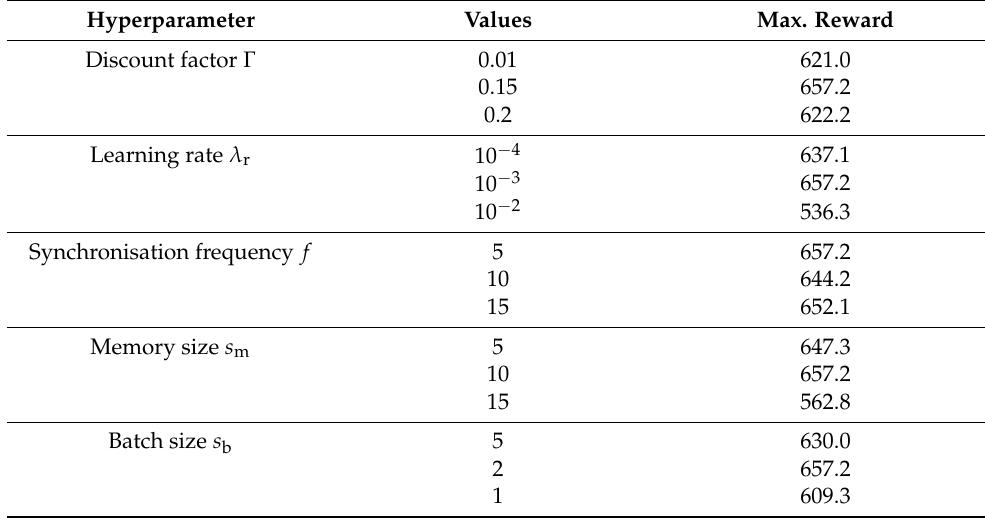
Table 3. Results of the analysis of sensitivity to the